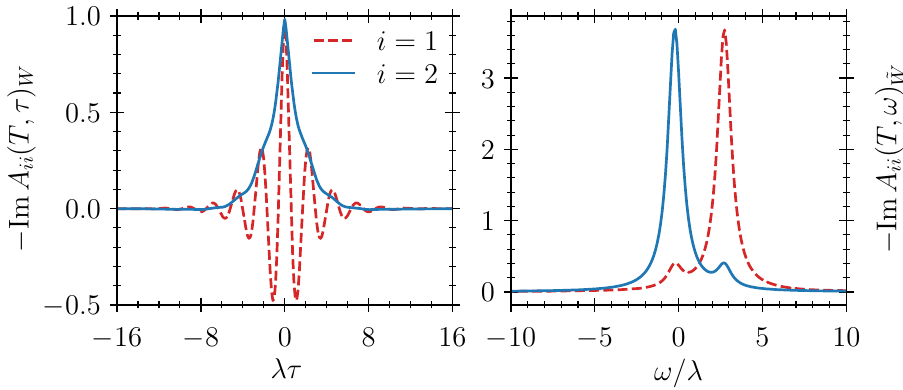
( T , τ ) ( T , ω ) and A ˜ W at ii W ii